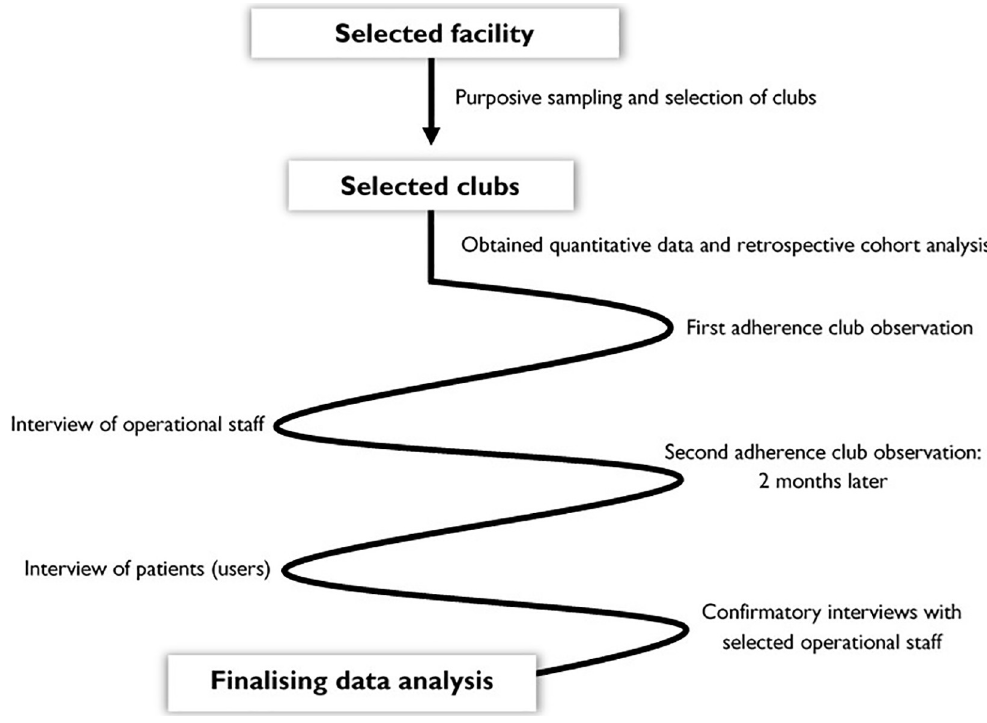
Fig 3. Data collection